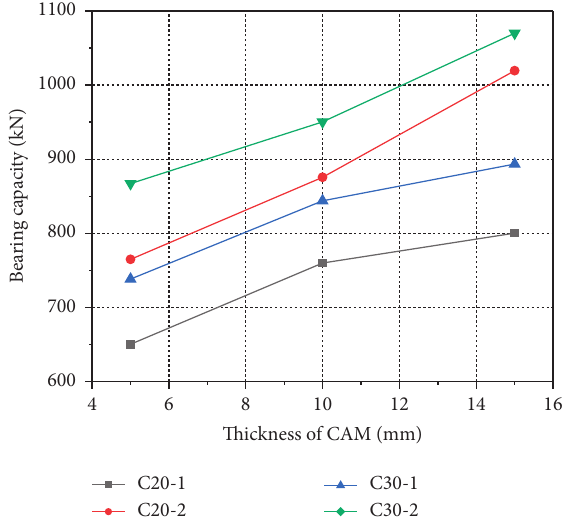
Figure 8: The effects of CAM thickness on bearing